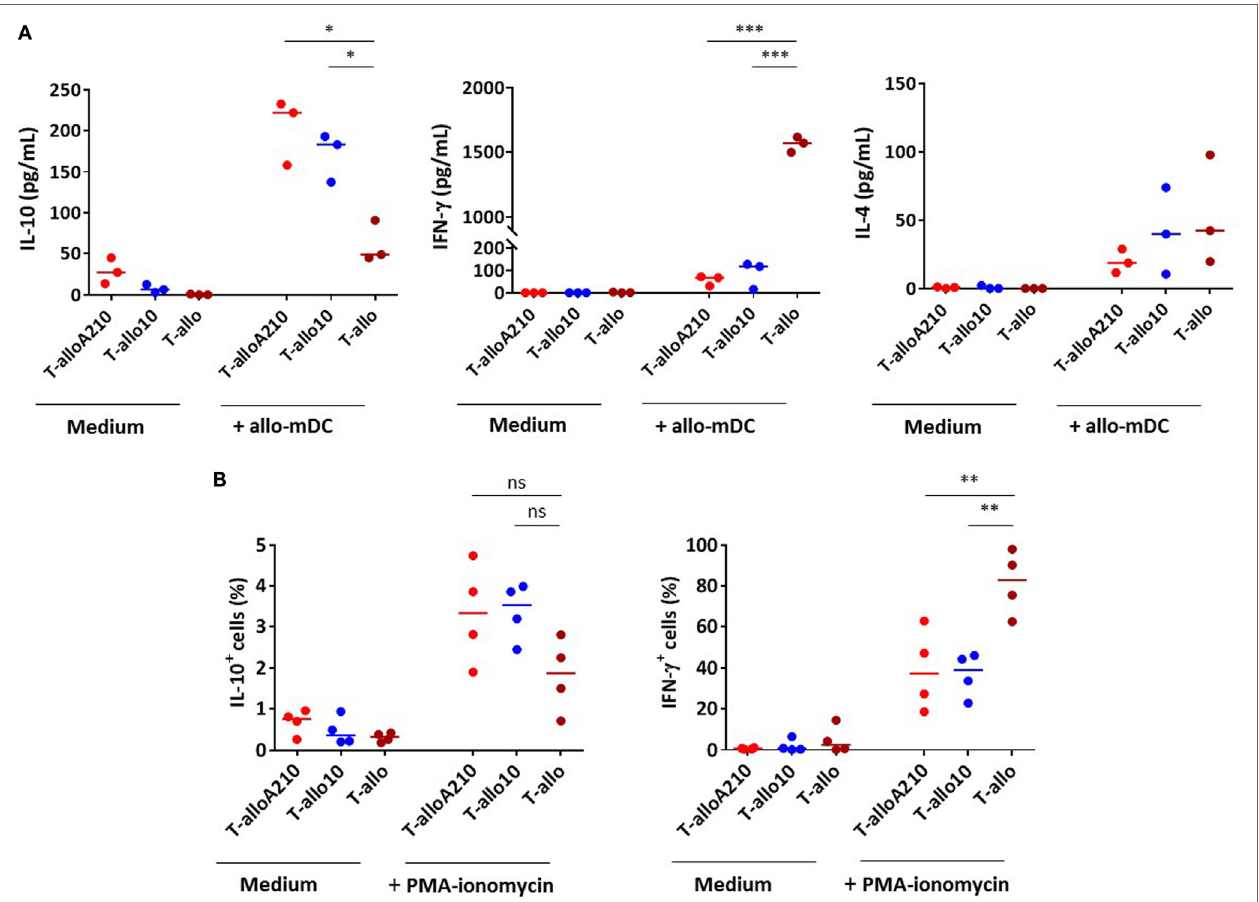
FigUre 3 | T-alloA210 and T-allo10 cells exhibit a similar cytokine production profile. DC differentiated in the presence of APVO210 (DC-A210), DC-10, and mature DC (mDC) were incubated for 10 days with allogenic T cells. T cells were cultured with allogenic DC-A210 + APVO210 (T-alloA210: 1 or 10 nM), with DC-10 + IL-10 (T-allo10) or with mDC (T-allo). (a) Levels of IL-10, IFN- γ , and IL-4 were evaluated by ELISA in culture supernatants after 48 h of stimulation with allogenic mDC (data are expressed in pg/mL). (B) Percentages of cells producing IL-10 and IFN- γ were evaluated by flow cytometry, using a secretion capture assay, after 6 h of stimulation with PMA and ionomycin. Median values are indicated, each dot represents a single donor. Paired t -tests with Bonferroni correction were performed for statistical analysis. * p < 0.05, ** p < 0.001, *** p <